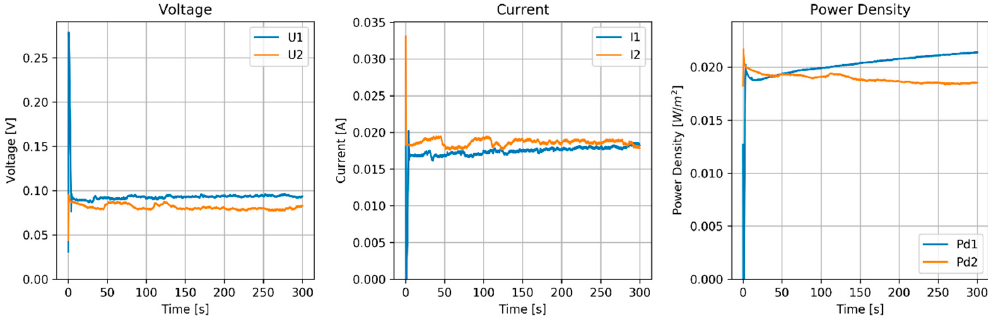
Figure 10. Results of MPPT test of the RED stack equipped with pseudo AEMs (Ag/AgCl) and pseudo CEMs (Zn). Flow rate (H and L) is 120 mL/min. RED with Constant Current Again the stack was tested with constant current as shown in Figure 11.